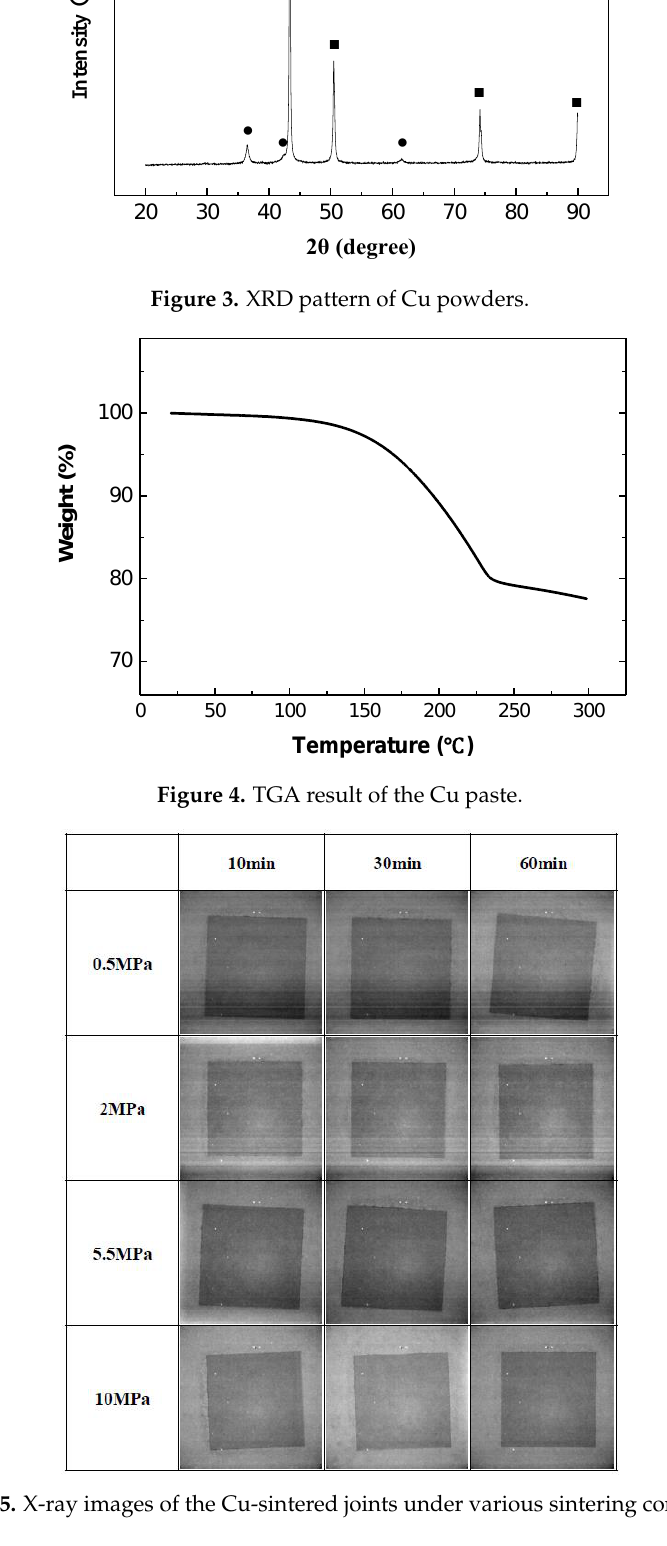
Figure 5. X-ray images of the Cu-sintered joints under various sintering conditions.